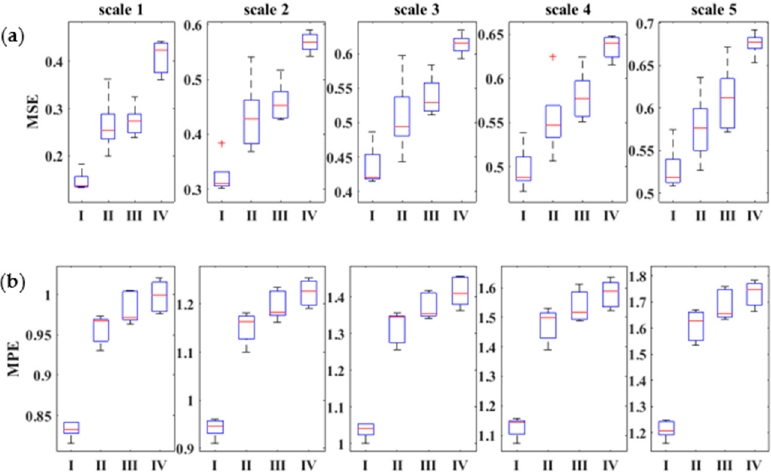
Figure 12. Boxplot for the MSE and MPE of the first five scale factors: ( a ) MSE (multi-scale entropy); and ( b ) MPE, where I is a healthy signal, II is inner race, III is outer race, and IV is rolling element.